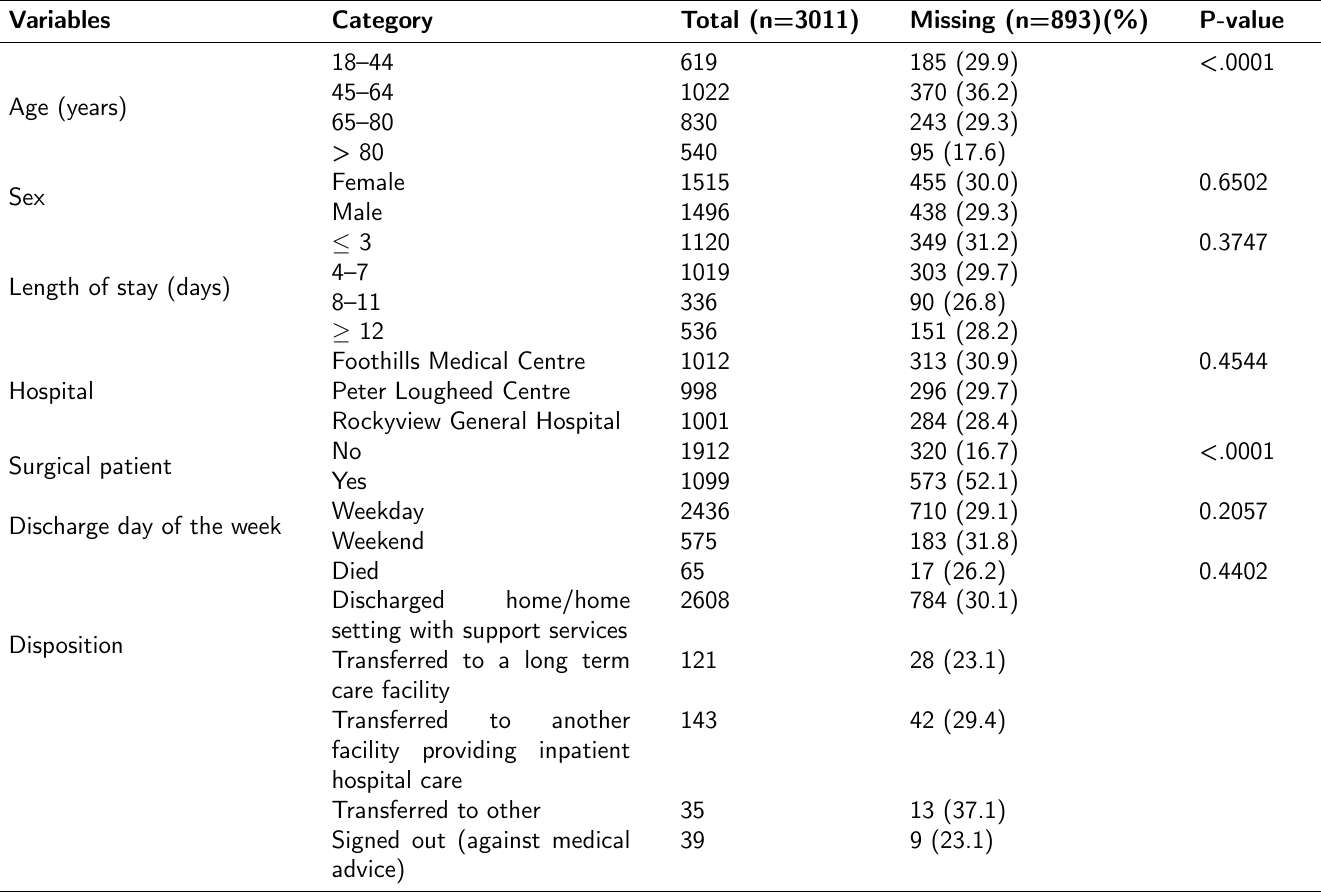
Table 1: Frequencies of patient and hospital characteristics assessed for association with missing discharge summaries in the EMR